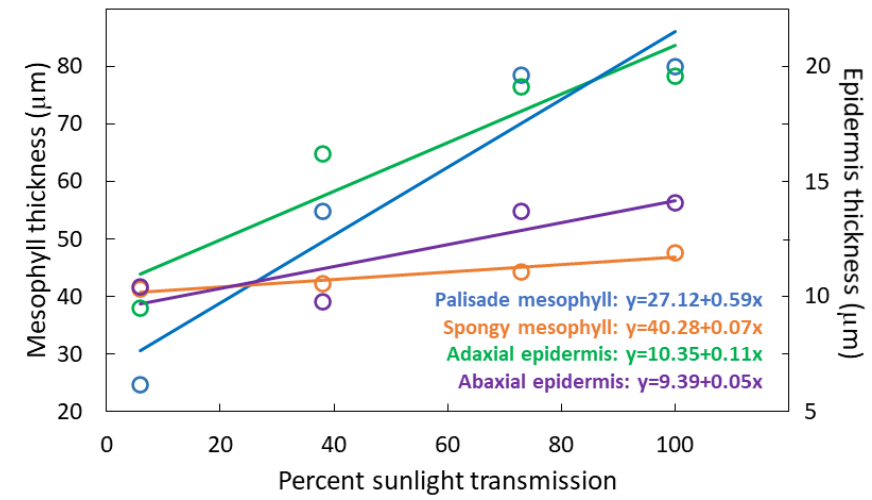
Figure 4. Thickness of four components of Serianthes nelsonii leaflets as influenced by percent sunlight during leaf growth. Markers are mean of 10 replications.